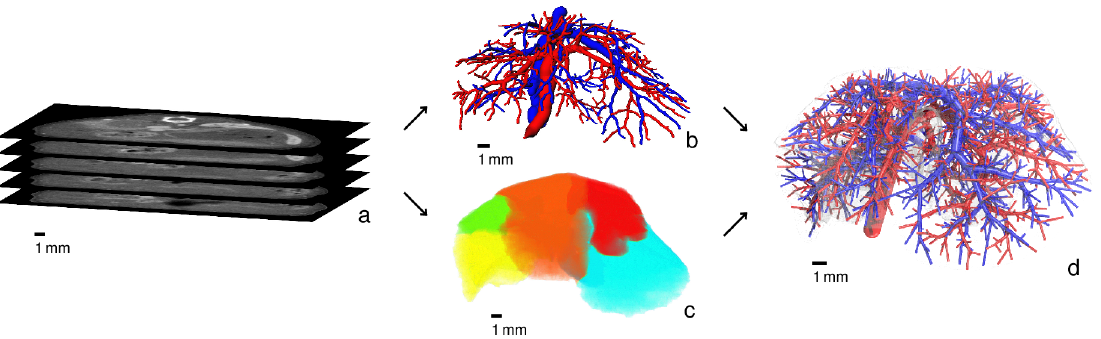
Figure 3. From in vivo scans to vascular geometry. Based on an in vivo micro-CT scan ( a ) of a mouse, vascular structures ( b ) in the liver are segmented and skeletonized. The supplying and draining vascular systems (SVS and DVS) are shown in red and blue, respectively. Furthermore, the liver is segmented and decomposed in lobes shown in different colors in ( c ). An algorithmic procedure is used to determine physiological vascular structures ( d ) with the desired level of detail, in our case 800 leaf nodes (end points) for each of the two trees are used.